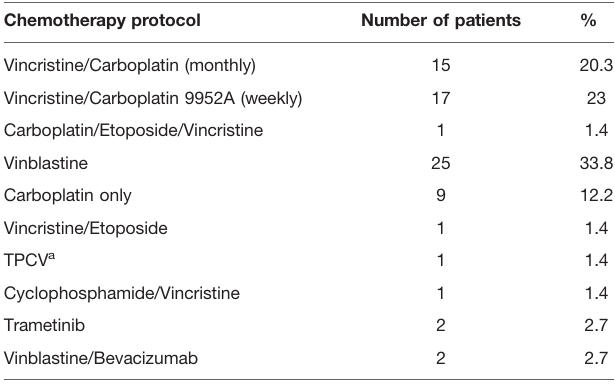
TABLE 3 | First chemotherapy regimen in children with OPG.